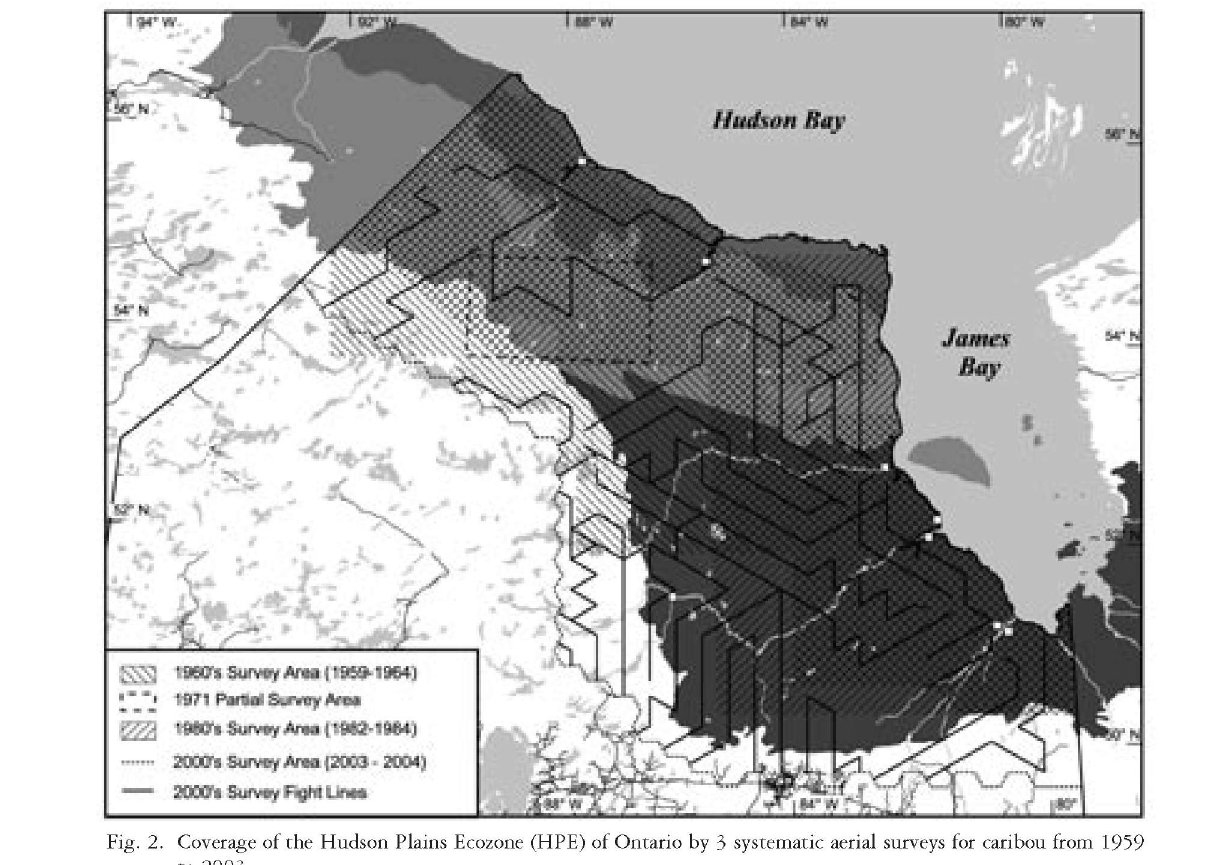
Fig. 2. Coverage of the Hudson Plains Ecozone (HPE) of Ontario by 3 systematic aerial surveys for caribou from 1959 to 2003 (southern boundary of Brokx's study area) during